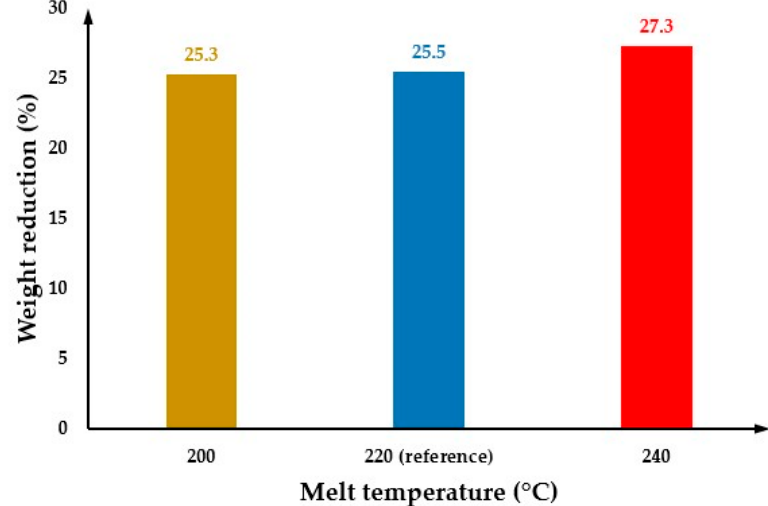
Figure 15. The weight reduction as a function of melt temperature.